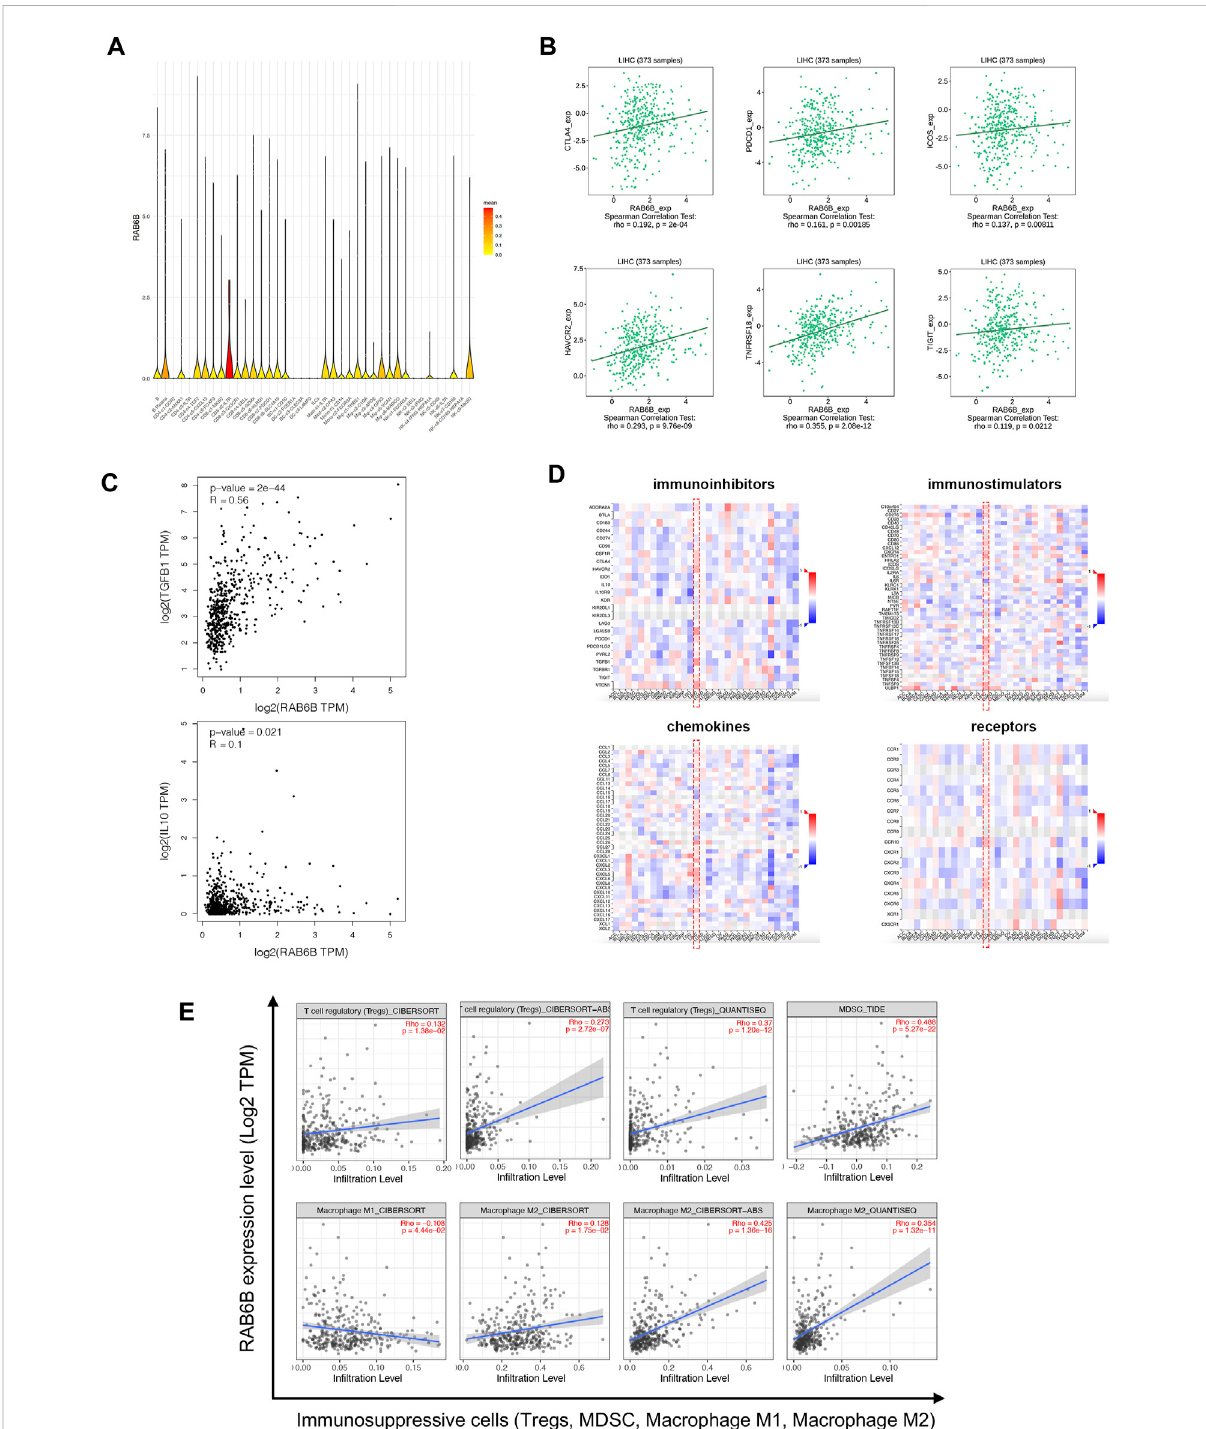
FIGURE 5 RelationshipbetweenRAB6Bexpressionandimmune-relatedmoleculesandcells. (A) RAB6BwasmainlyenrichedinCD8+Tcellsaccordingto single-cell RNA-sequencing results, which were analyzed by SMART-seq2. (B) Scatter plot showed that RAB6B expression was positively correlated with various immune checkpoint molecules, including CTLA4, PDCD1, ICOS, HAVCR2, TNFRSF18, and TIGIT. (C) RAB6B expression was positively correlated with TGFB1 and IL10 based on the GEPIA database. (D) The heatmap (red dashed rectangle) showed the correlation betweenRAB6B expression and various immunoinhibitors, immunostimulators, chemokines, and receptors in HCC from the TISIDB database. (E) RAB6B was positively correlated with Tregs, MDSC, and M2 macrophages in fi ltration, but negatively correlated with M1 macrophages in fi ltration by using the TIMER2.0 database. Tregs, regulatory T cells; MDSCs, myeloid-derived suppressor